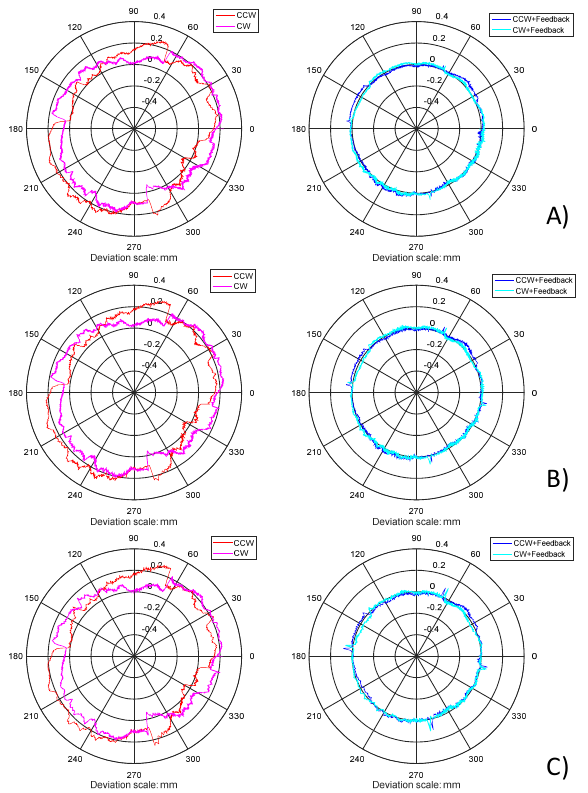
Figure 17. ballbar results for feed rates for one run. ( A ) 250 mm/min; ( B ) 500 mm/min; ( C ) 1000 Figure 17. Ballbar results for feed rates for one run. ( A ) 250 mm / min; ( B ) 500 mm / min; ( C ) 1000 mm / mm/min.